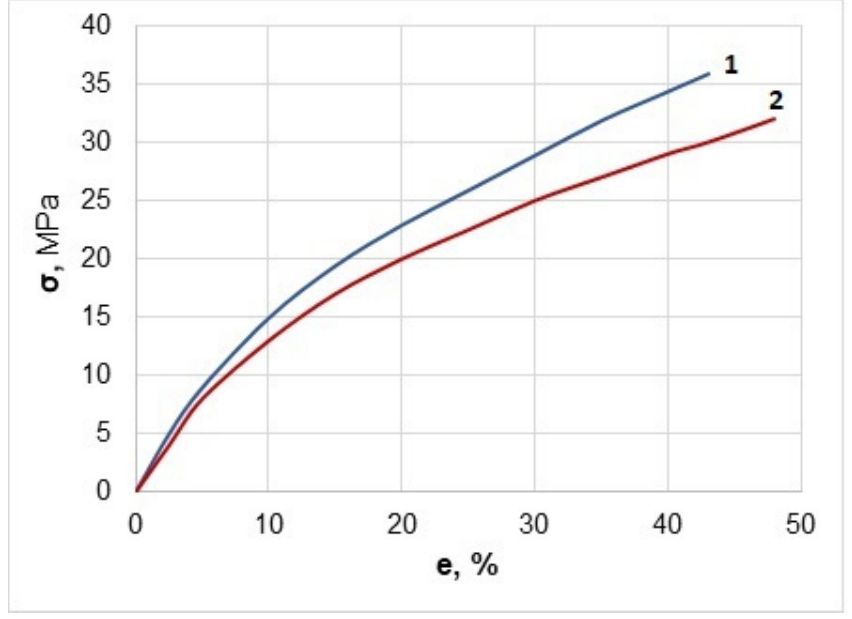
Figure 7. Deformation–stress diagram for TAB ( 1 ) and TBC ( 2 ) in dry state. After exposure to water, the strength of the samples decreased, but this decrease was relatively small and did not exceed 10% due to high hydrophobicity of the studied cellulose esters (Figure 8).